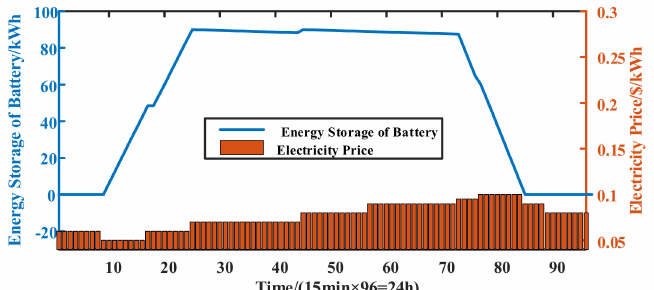
Figure 9. Energy storage of backup batteries in the 5G macro BS network.